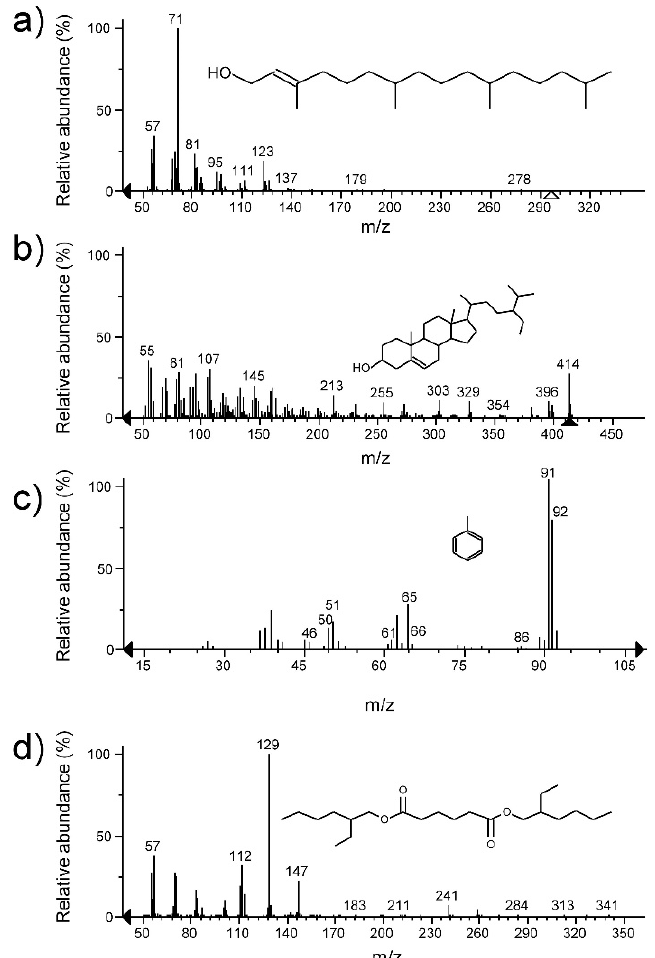
Figure 2. Mass spectra and chemical structures identified in the fractions F6 and F10 from the M5L extract of L. hirta , Phytol ( a ) and α -sitosterol ( b ). In the fraction F10 from the M6LFr extract of A. ochroleuca , Toluene ( c ). In the fractions F2, F4 and F5 from the M4LS extract of A. porophyllum , Hexanedioic acid, bis(2-ethylhexyl) ester ( d ).